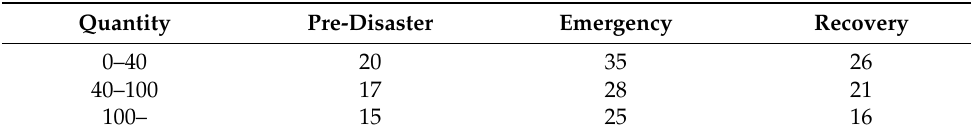
Table 4. Procurement price mechanism.